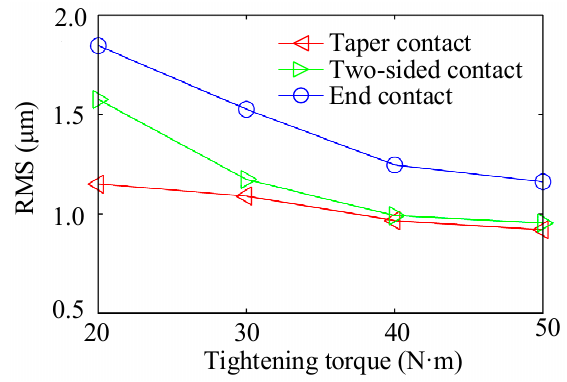
Figure 17. Effect of contact state on radial vibration.